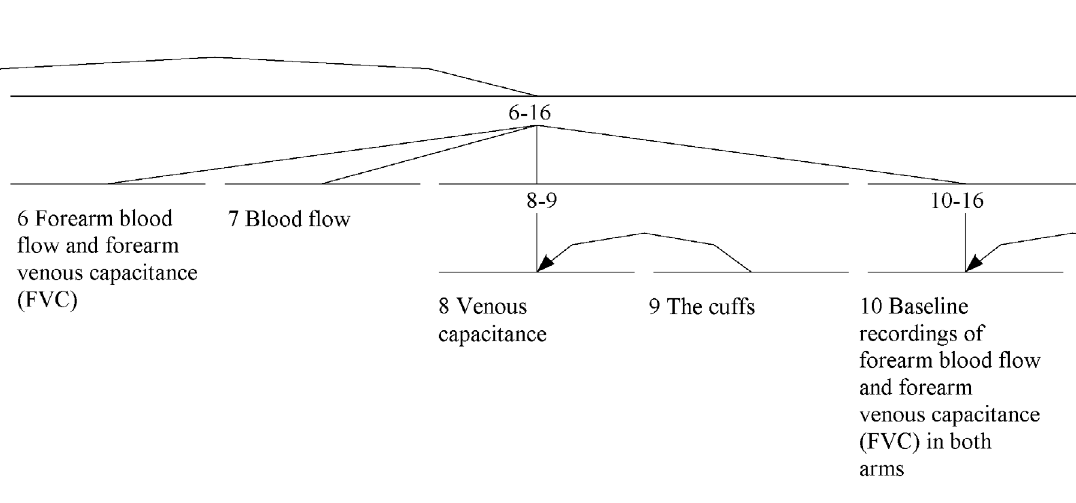
Figure 5. Theme pattern in the third subsection of Methods In the TT, this pattern is broken since, although units 7 and 8 keep the same Theme and voice, units 6 and 10 are rendered as reflexive passives with fronted